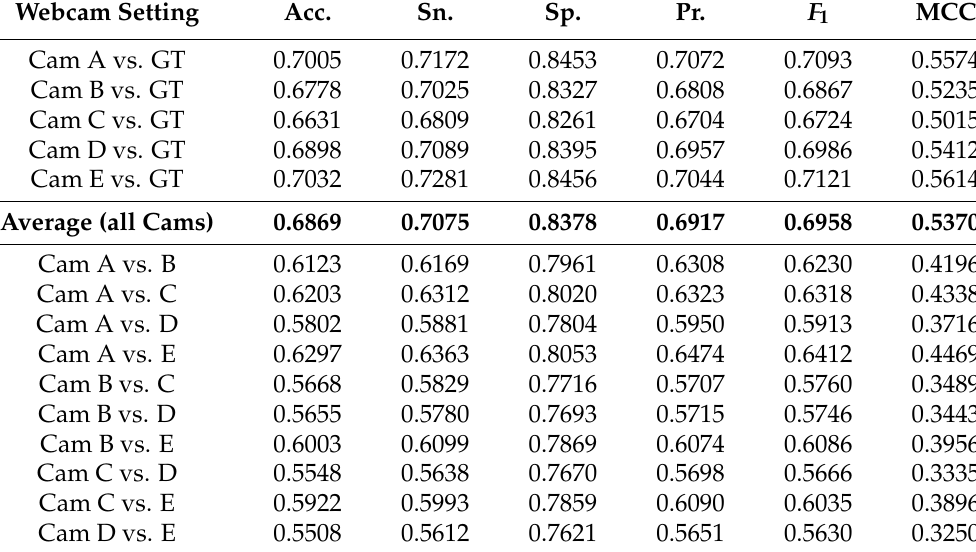
Table 5. Performance evaluation of proposed system for eye position attributes detection. Acc.: accuracy, Sn.: Sensitivity, Sp.: Specificity, Pr.: Precision, F 1 : F 1 score, MCC: Matthews Correlation Coefficient, GT: Ground